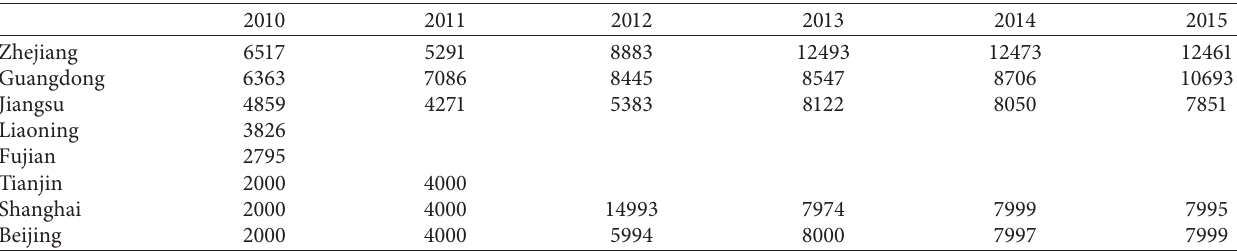
Table 3: The top 5 provinces for inflow populations in 2010–2015.